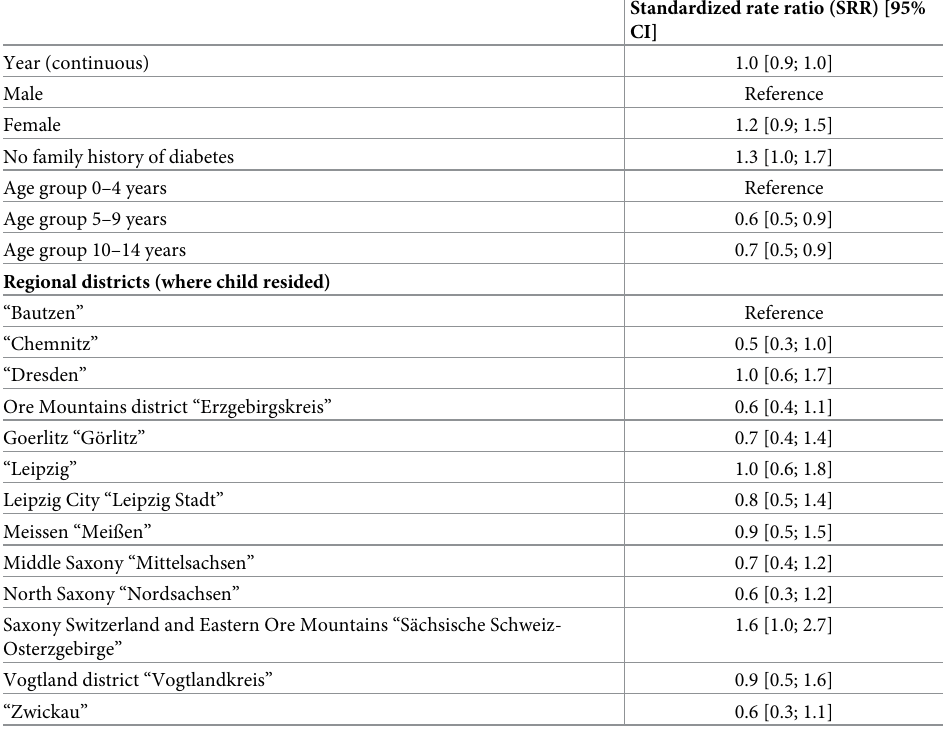
Table 2. Results of the Poisson regression analysis in relation to ketoacidosis.